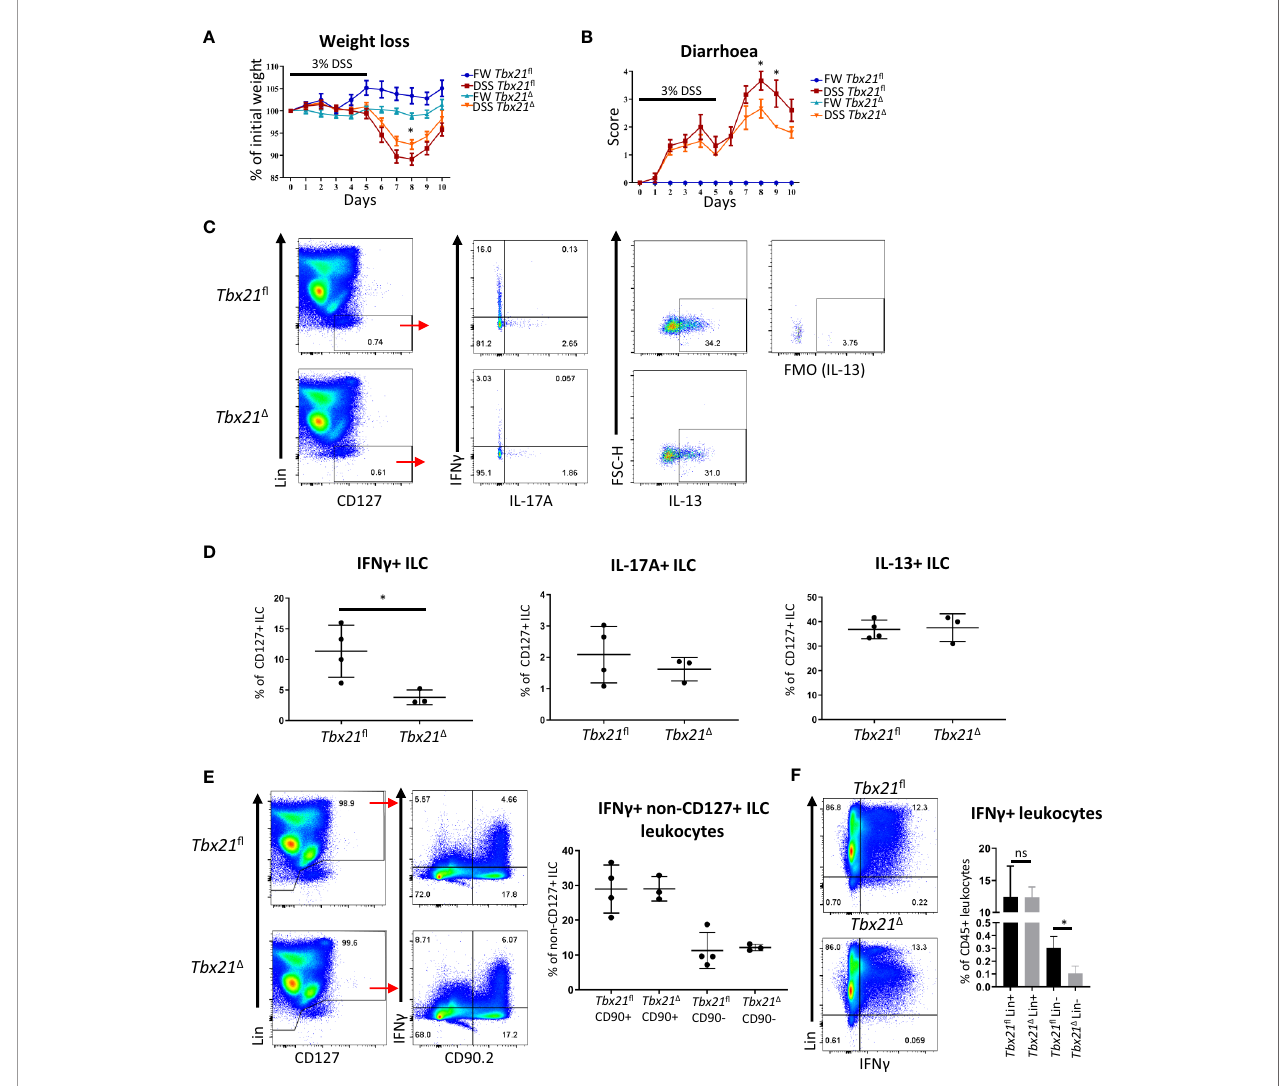
FIGURE 4 | Induced T-bet depletion causes milder DSS-elicited colitis. Mice received DSS in the drinking water for clinical investigation. (A, B) Tbx21 fl and Tbx21 D mice pre-treated with tamoxifen were exposed to 3% DSS in the drinking water for 5 days followed by a period of rest (n=8-14). Control mice receiving FW without DSS were included in the study. (A) Daily percentual weight change to body weight at the start and (B) daily diarrhoea scoring are illustrated. (C – F) cLP leukocytes were isolated 2 days after DSS withdrawal and re-stimulated with PMA and ionomycin for 3 hours prior to analysis. (C) Flow cytometry analysis of IFN g , IL-17A and IL-13 expression in live CD45 + Lin - CD127 + ILC and (D) statistical analysis of cytokine expression are shown (n=3-4). IFN g expression in (E) CD90.2 + and CD90.2 - non-ILC leukocytes and (F) live CD45 + Lin - and Lin + leukocytes in addition to respective statistical analyses are shown (n=3-4). *p < 0.05, ns, non-signi fi